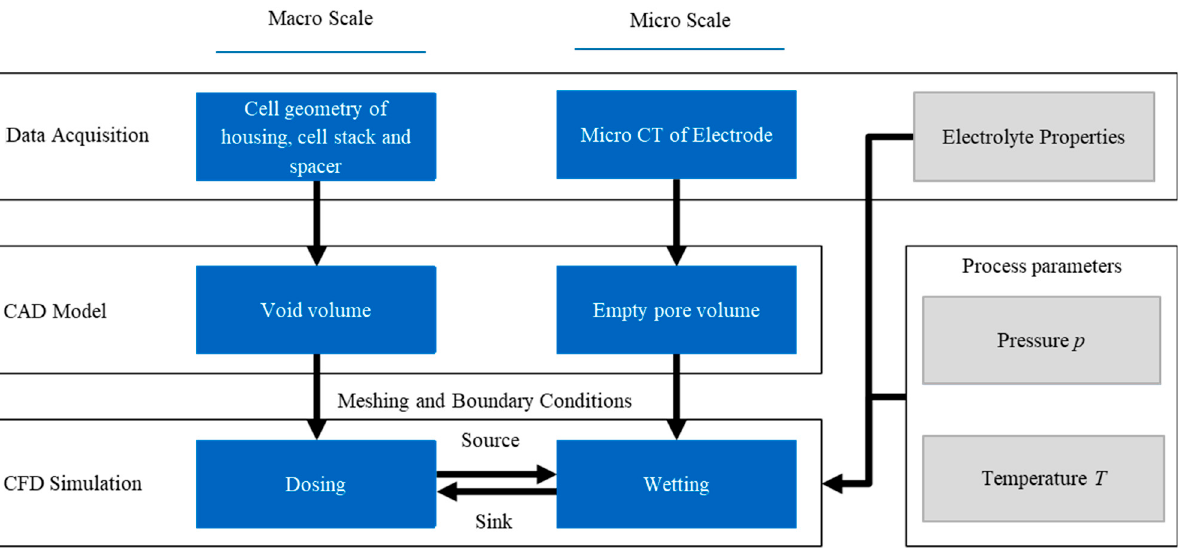
Figure 1. Overall concept of the model showing how the macro and micro scales are built and con- nected to represent the entire filling process. connected to represent the entire filling